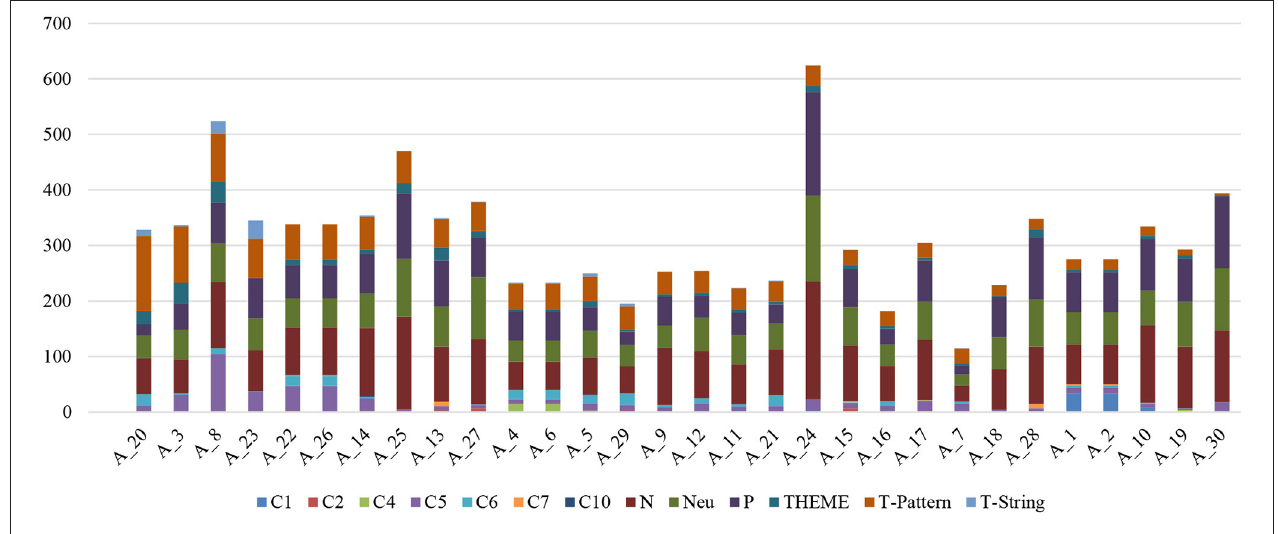
FIGURE 10 | Ranking of the selected articles with respect to the categorization criteria from the T-Pattern